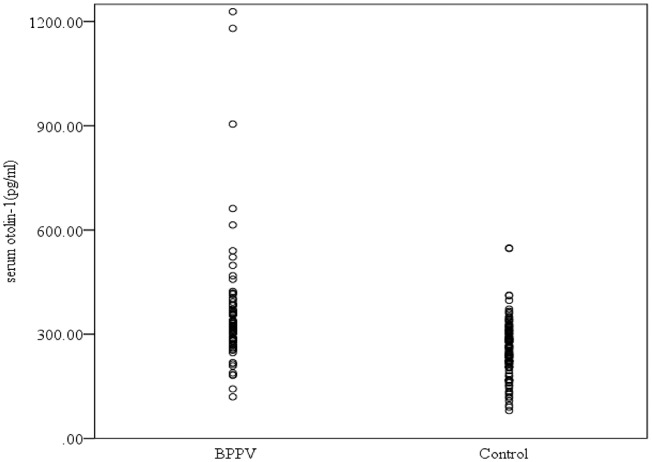
Serum concentrations of otolin-1 in subjects with BPPV and healthy controls.